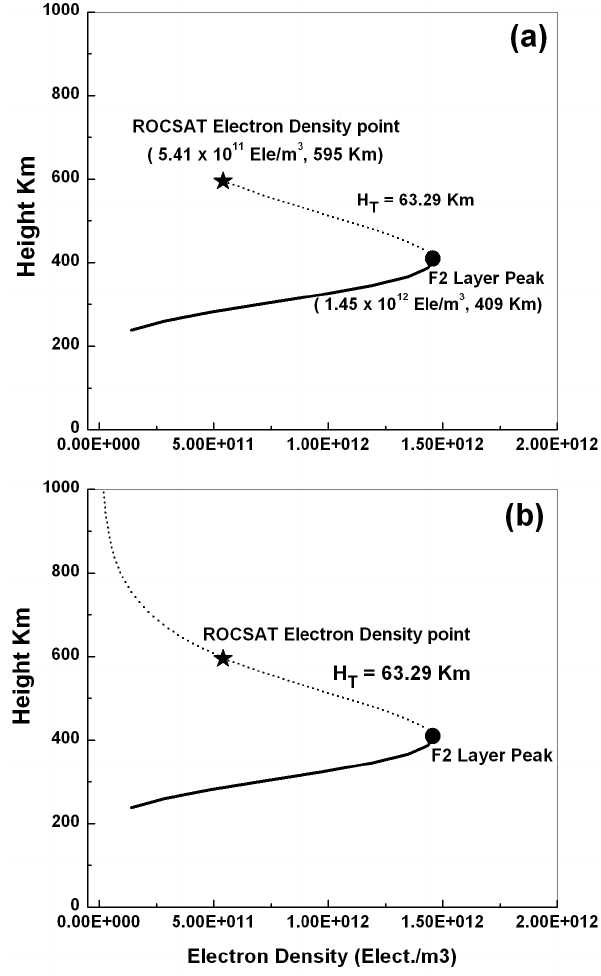
Fig. 1. (a) Determination of topside effective scale height ( H T ) by fitting α -Chapman function between F2-layer peak and ROCSAT electron density point. (b) Reconstruction of topside electron den- sity profile using above derived topside effective scale height ( H T )